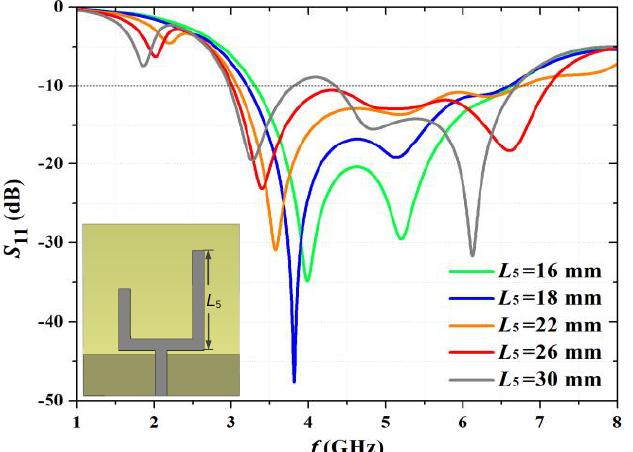
Figure 7. Simulated reflection coefficient of the ATPA as a function of microstrip-line length L 5 . ( L 1 = 12 mm, L 2 = L 3 = 6.5 mm, L 4 = 16 mm, L 6 = 11 mm, 45×40 mm 2 ).